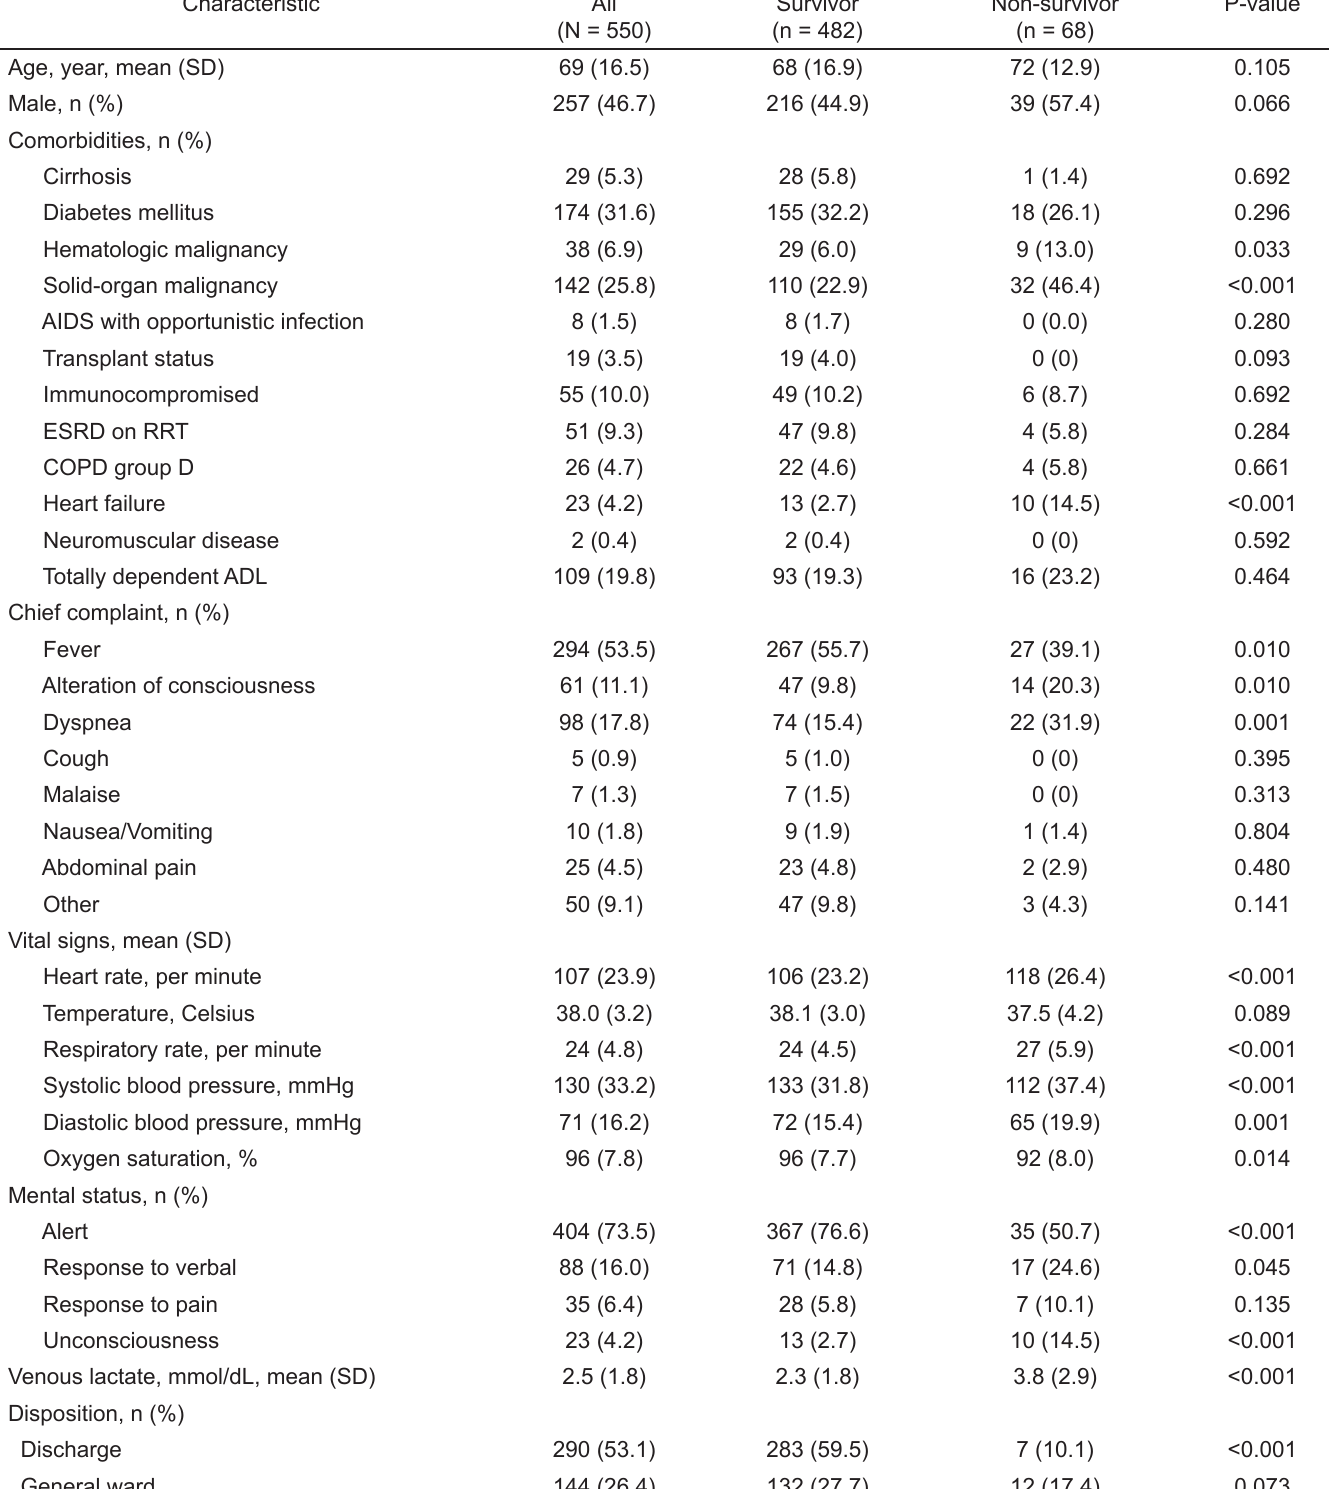
Table 1. Baseline characteristics of patients stratified by 28-day